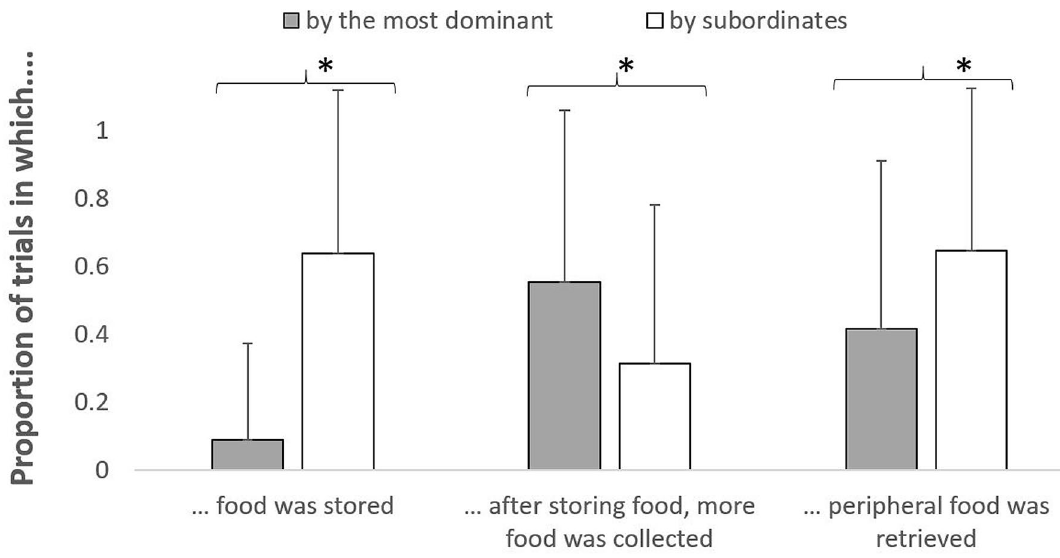
Figure 1. For dominants and subordinates separately, mean (+ SD) proportion of trials in which macaques stored food, in which they collected more food after storing one piece, and in which they retrieved peripheral food. Significant differences are marked with an